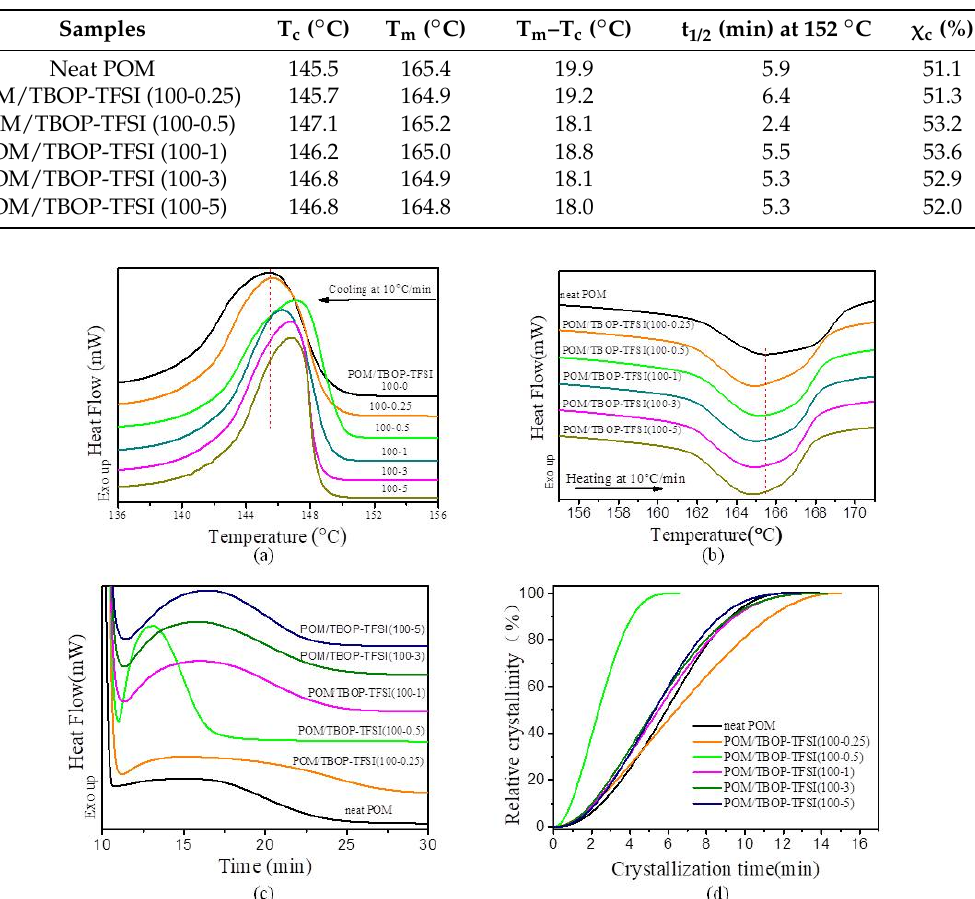
Figure 3. Differential scanning calorimetry (DSC) curves for POM/TBOP-TFSI composites: ( a ) first cooling and ( b ) second heating (after 5 min isothermal for erasing heat history); ( c ) isothermal crystallization process at 152 ◦ C; ( d ) relative crystallinity as a function of crystallization time at 152 ◦ C.